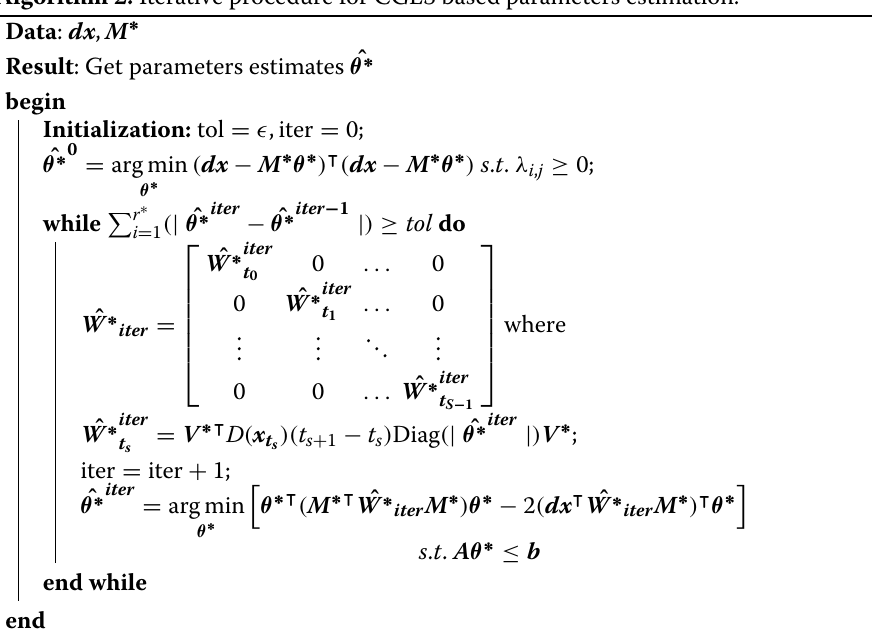
Algorithm 2: Iterative procedure for CGLS based parameters